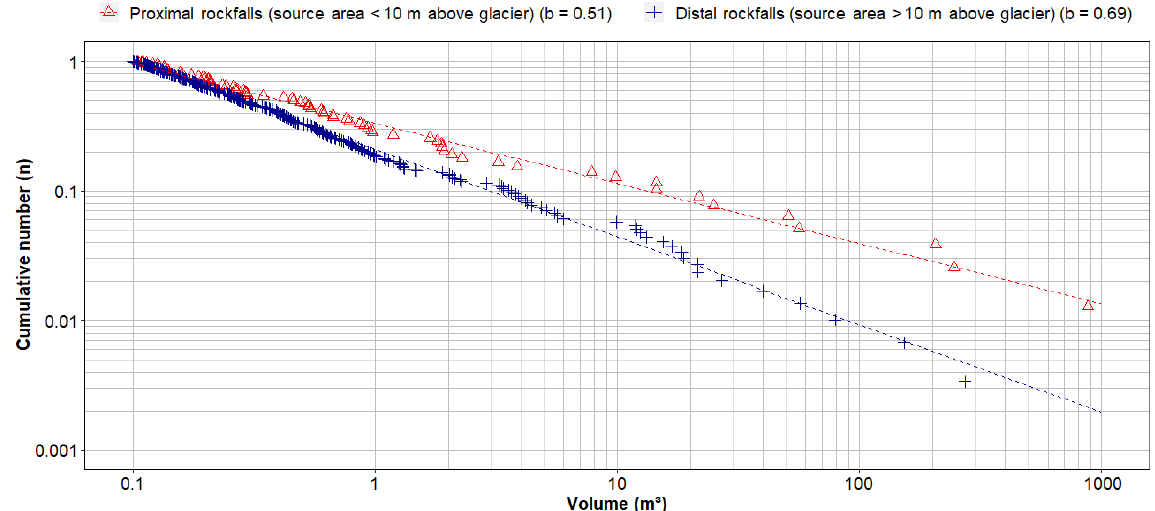
Figure 12. Magnitude–frequency distributions for glacier-proximal rockfalls and glacier-distal rockfalls. Proximal rockfalls ( b = 0 . 51) are fitted by a significantly flatter regression line than distal rockfalls ( b = 0 . 69), indicating an increased occurrence of large events in recently deglaciated areas.